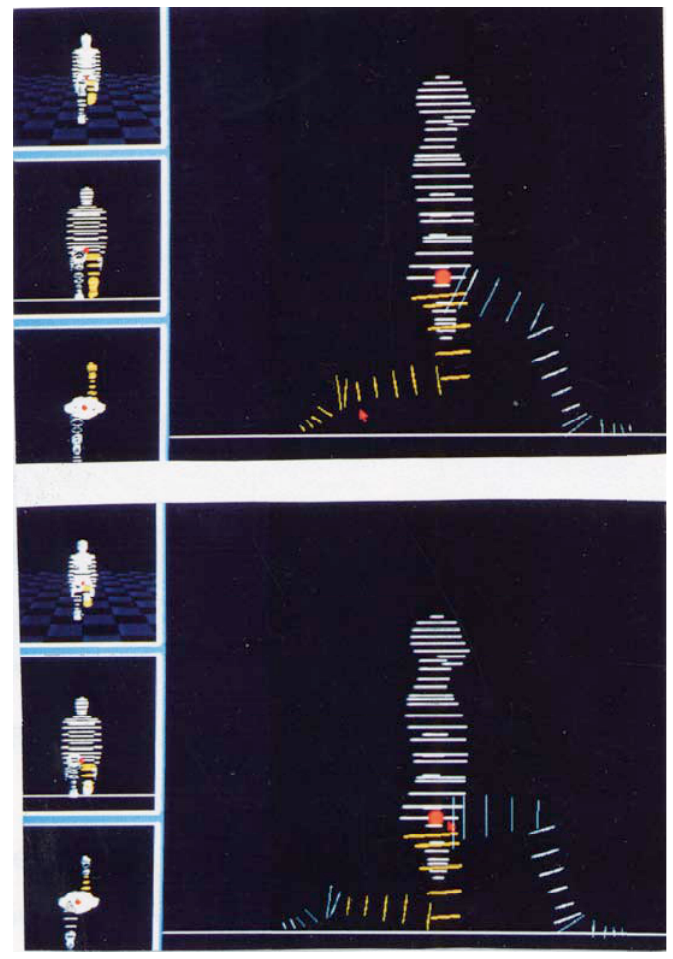
Figure 3.5 Creating a shape using inverse kinematics in the sequence